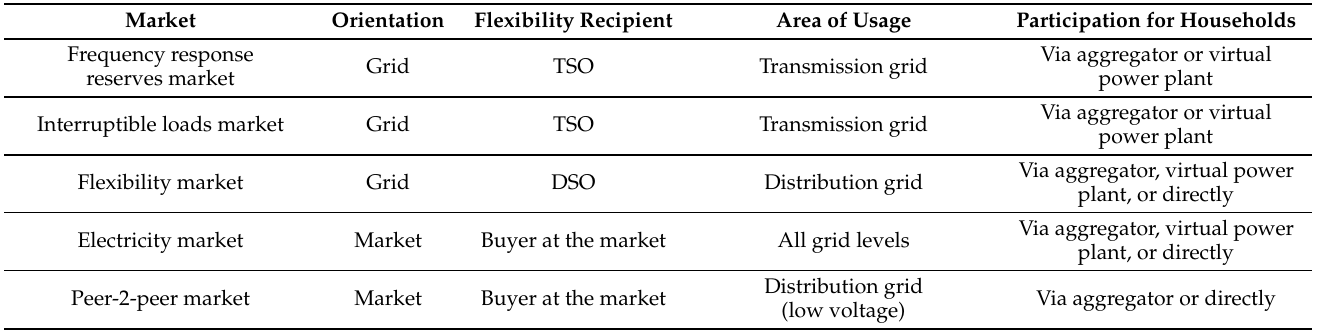
Table 2. Summary of available markets for the flexibility available in Germany, including their main